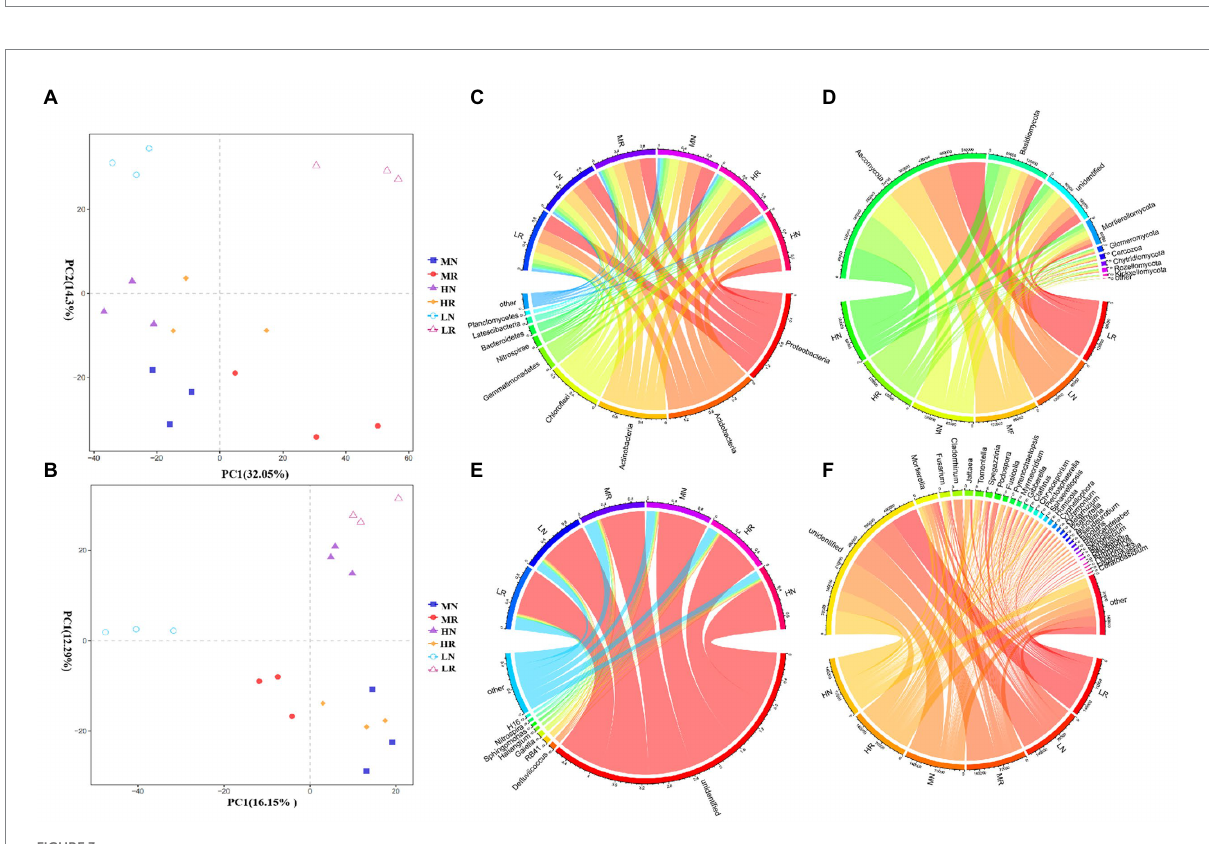
FIGURE 3 The PCoA diagram and relative abundances of dominant microorganisms in different treatments. (A) PCoA diagram of bacterial and (B) fungal microbial communities; (C) dominant bacterial and (D) dominant fungal species composition at the phylum level; (E) dominant bacterial and (F) dominant fungal species composition at the genus level.